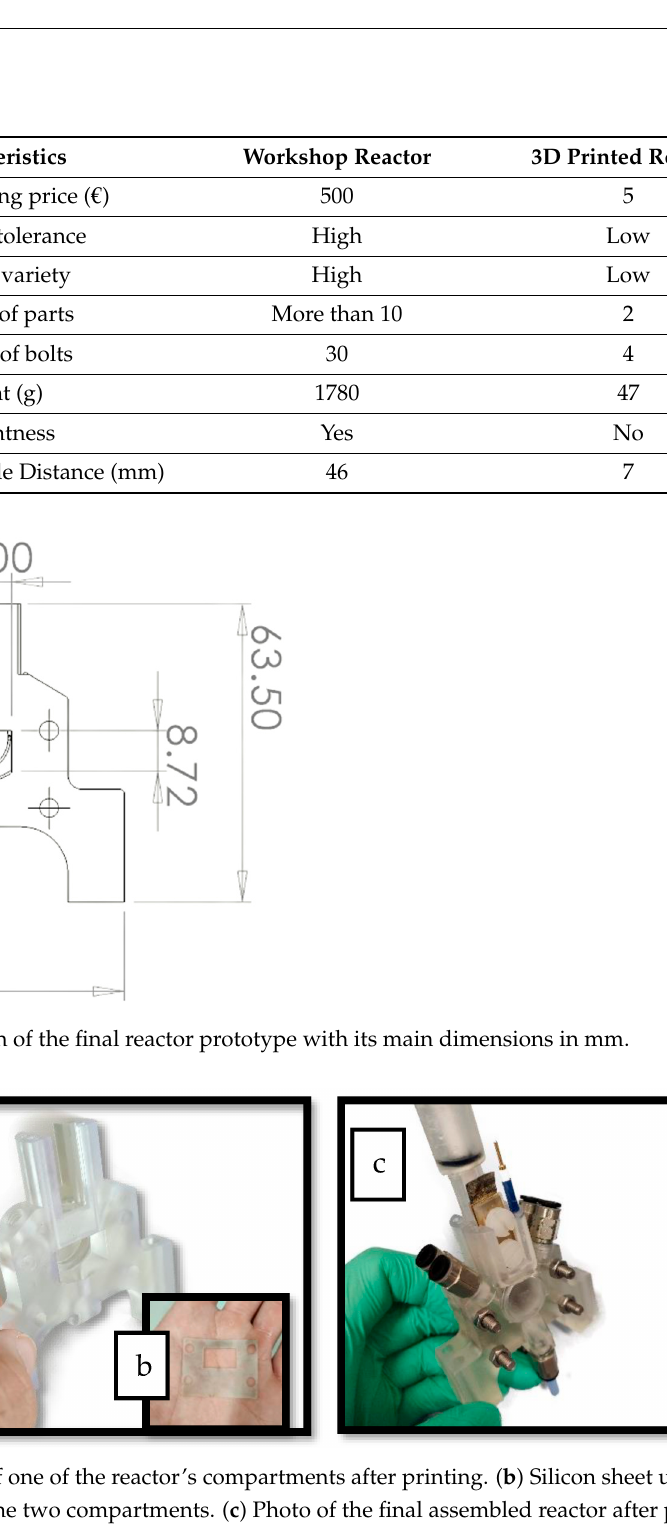
Figure 5. The old CNC manufactured reactor on the left compared with the novel 3D printed reactor on the right.